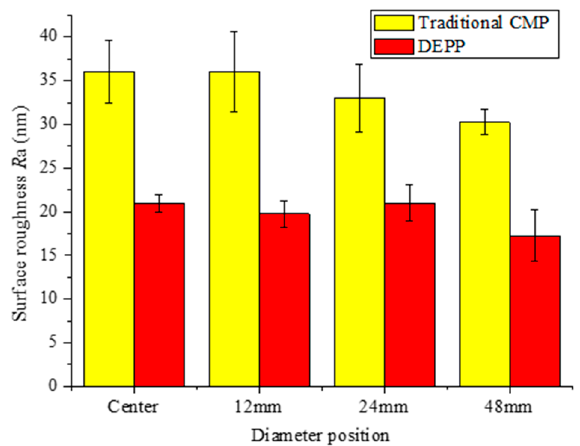
Figure 15. Average surface roughness at different positions after polishing for 4 h.